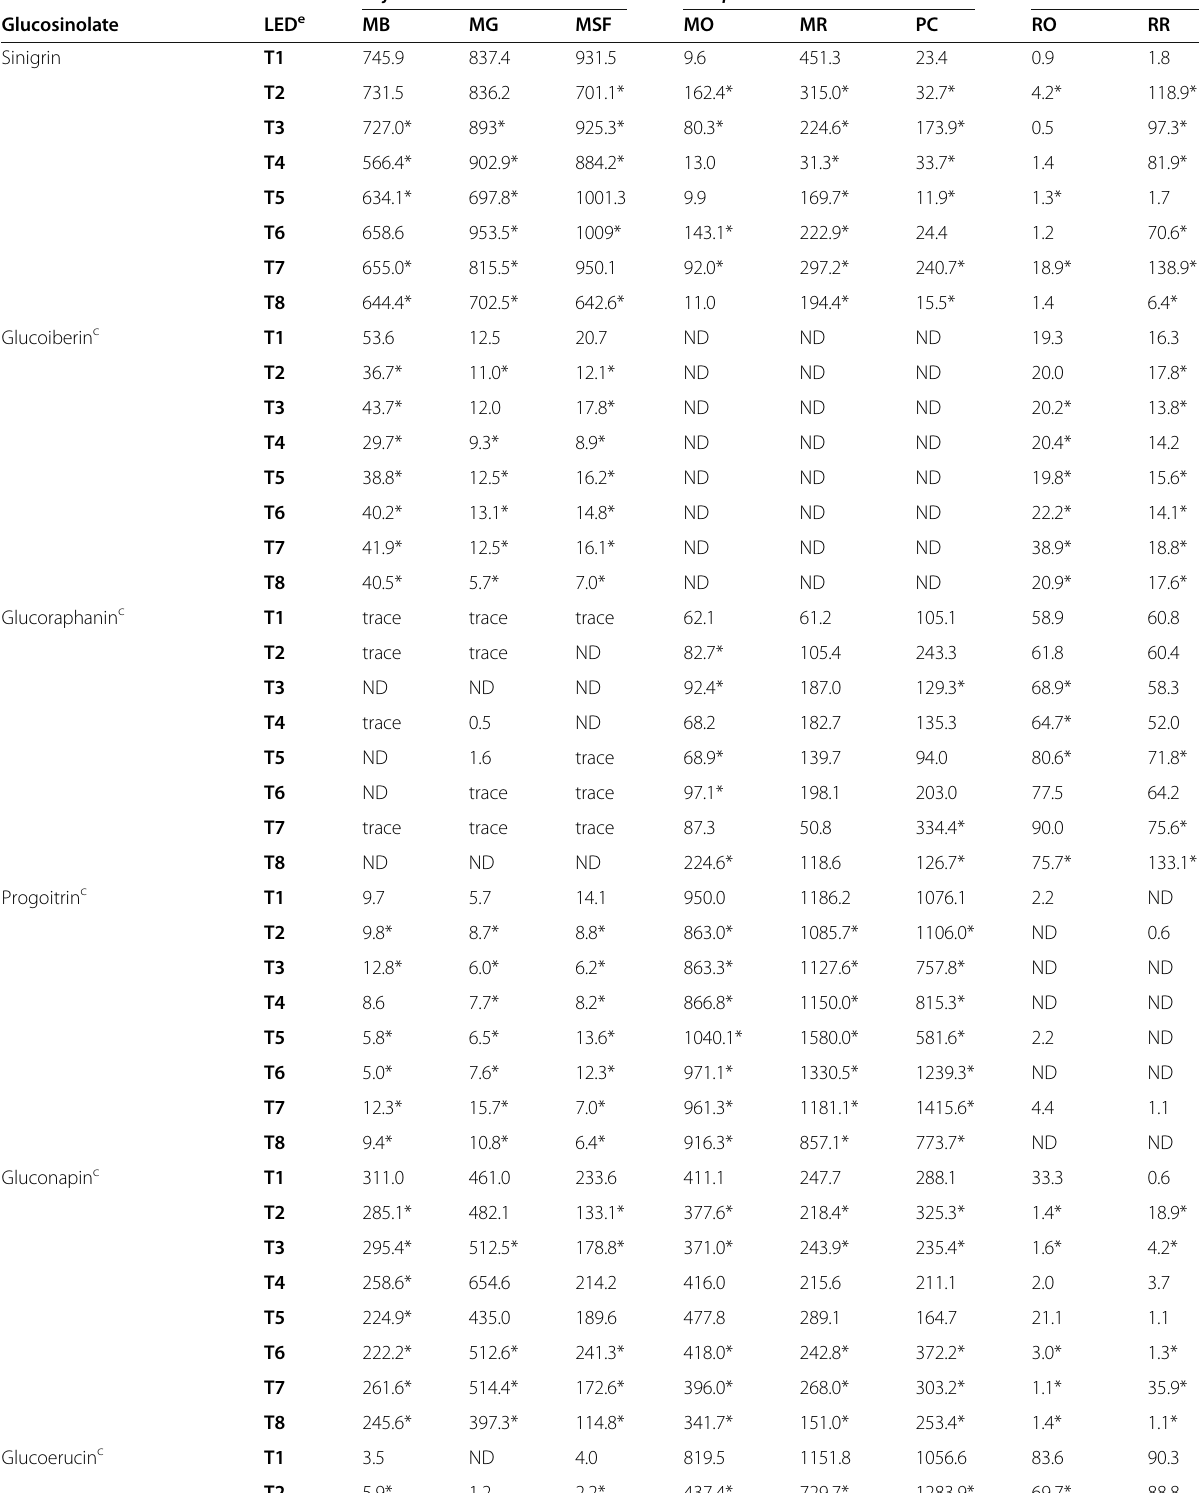
Table 3 Concentration of the glucosinolates identified in the microgreens under combined red, blue and amber LED. a Values are expressed as μ g sinigrin b , glucobrassicin c or gluconasturtiin d equivalents per g of microgreens (dry weight) B. juncea B.